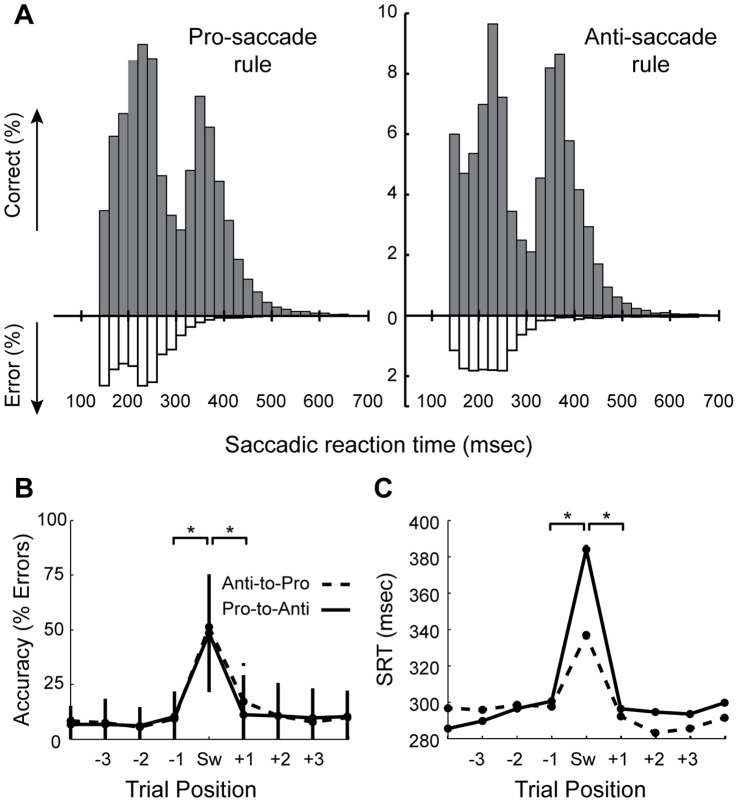
Saccade overriding task Performance.A. Saccadic reaction time (SRT) distributions for pro- and anti-saccade responses. Under each rule, a bi-modal distribution was obtained, which indicates that the monkeys used two different strategies to prepare their responses. Specifically, the animals used two different methods for rule application, which were intertwined with their speed-accuracy trade-off. Error trials were mostly generated under the internally-cued fast preparatory mode, and very rarely if at all under the slower controlled preparatory mode. B. Performance by trial-position, with respect to the switch trial. C. SRT by trial-position, with respect to the switch trial. In B&C, statistically significant switch costs are evident (* p<0.001, Wilcoxon ranked sum test). Switch costs are defined as a drop in performance on a switch trial, relative to repeat trials. On average, the correctly performed rule-switch trials were performed at latencies above 300 msec, which indicates that the monkeys had to prepare for the saccade using the slower controlled mode in order to successfully perform a rule-switch trial. Performance dropped to 50% on average (for both rules) on switch trials, which indicates that for approximately half of these trials, the monkeys prepared their response automatically based upon the rule in the previous trial, which should always lead to an error when faced with a switch trial.